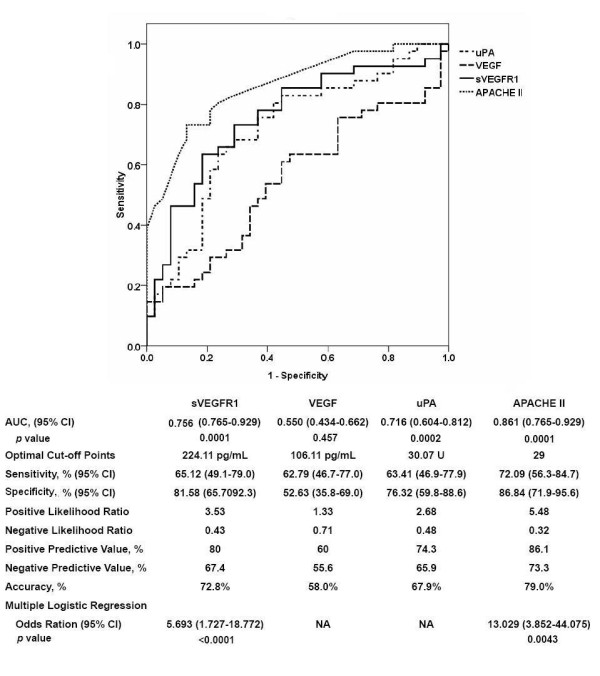
Receiver operator characteristic (ROC) curves of plasma biomarker levels and Acute Physiology and Chronic Health Evaluation II (APACHE II) scores for predicting 28-day mortality. ROC curves plotted for studying the utility of plasma biomarker levels and APACHE II scores in predicting 28-day mortality of pneumonia-related septic shock patients are shown. The areas under the ROC curves (AUCs) for soluble vascular endothelial growth factor receptor 1 (sVEGFR1), urokinase plasminogen activator (uPA), and APACHE II scores were significantly greater than 0.5. The optimal cutoff points for each biomarker and APACHE II score, along with their predictive values for the 28-day mortality of patients with pneumonia-related septic shock, are listed in the attached table. CI, confidence interval; VEGF, vascular endothelial growth factor.